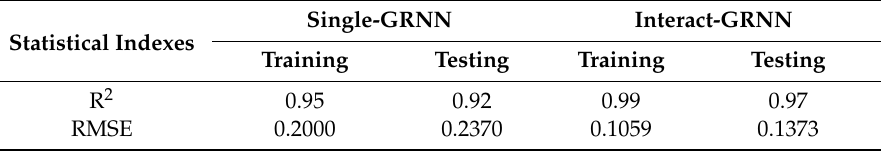
Table 8. Statistical indexes of generalized regression neural network (GRNN)